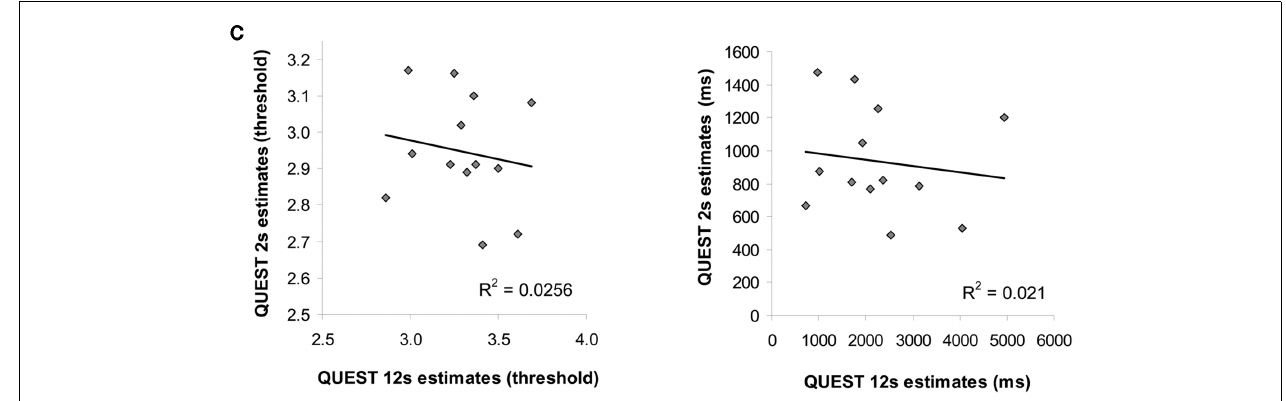
(“same” or “different”). Expected responses according to the task are indicated on the top right corner. Both color and time task required attention and motivation throughout the task since the number of flashing circles and their appearances were unexpected [number of circles per trial varied across trials and stimulus appearances were asynchronous (different SOA)]. Bottom: correlation between individuals’ longer temporal duration discrimination performance and color discrimination performance is not significant. Each point in the scatter plots (left plot n = 13, right plot n = 12 without the outlier) represents one individual. (C) Correlation between shorter duration and longer duration discrimination abilities across all participants based on a finer adaptive QUEST procedure (see Materials and Methods). Each point in the scatter plots (left plot in threshold values, right plot same data in ms units) represents data from one participant. For shorter 2s on y axis, and for longer 12s on x axis, the number of ms (right plot) represents the duration difference needed for that individual to discriminate durations of that length at a fixed accuracy level of 75%.Thus, the duration difference for shorter durations does not correlate with the duration difference for longer durations, consistent with the results presented in Figure 2A bottom